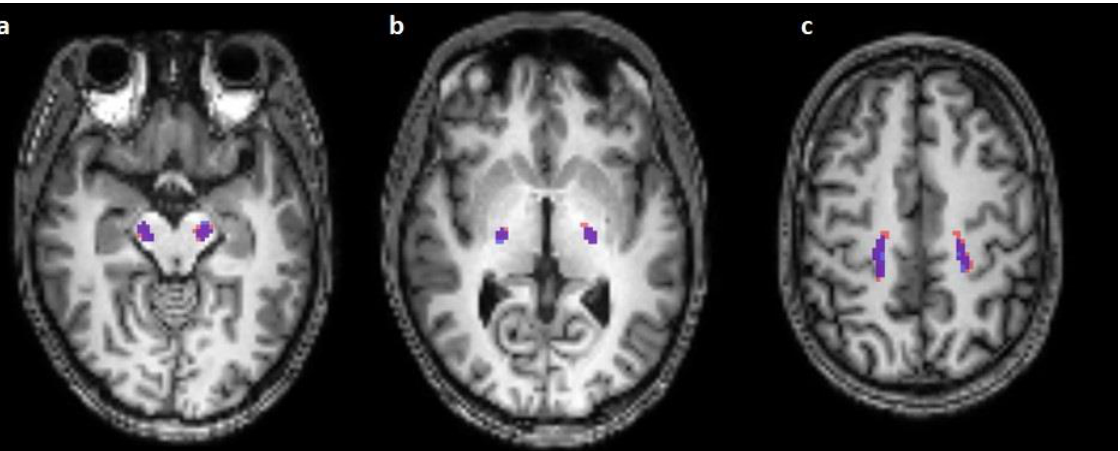
Figure 1. Comparison of the predicted (blue) and reconstructed (red) course of the corticospinal tract on horizontal T1-weighted images in the mesencephalon ( a ), the crus posterior of the internal capsule ( b ), and in the centrum semiovale ( c ).